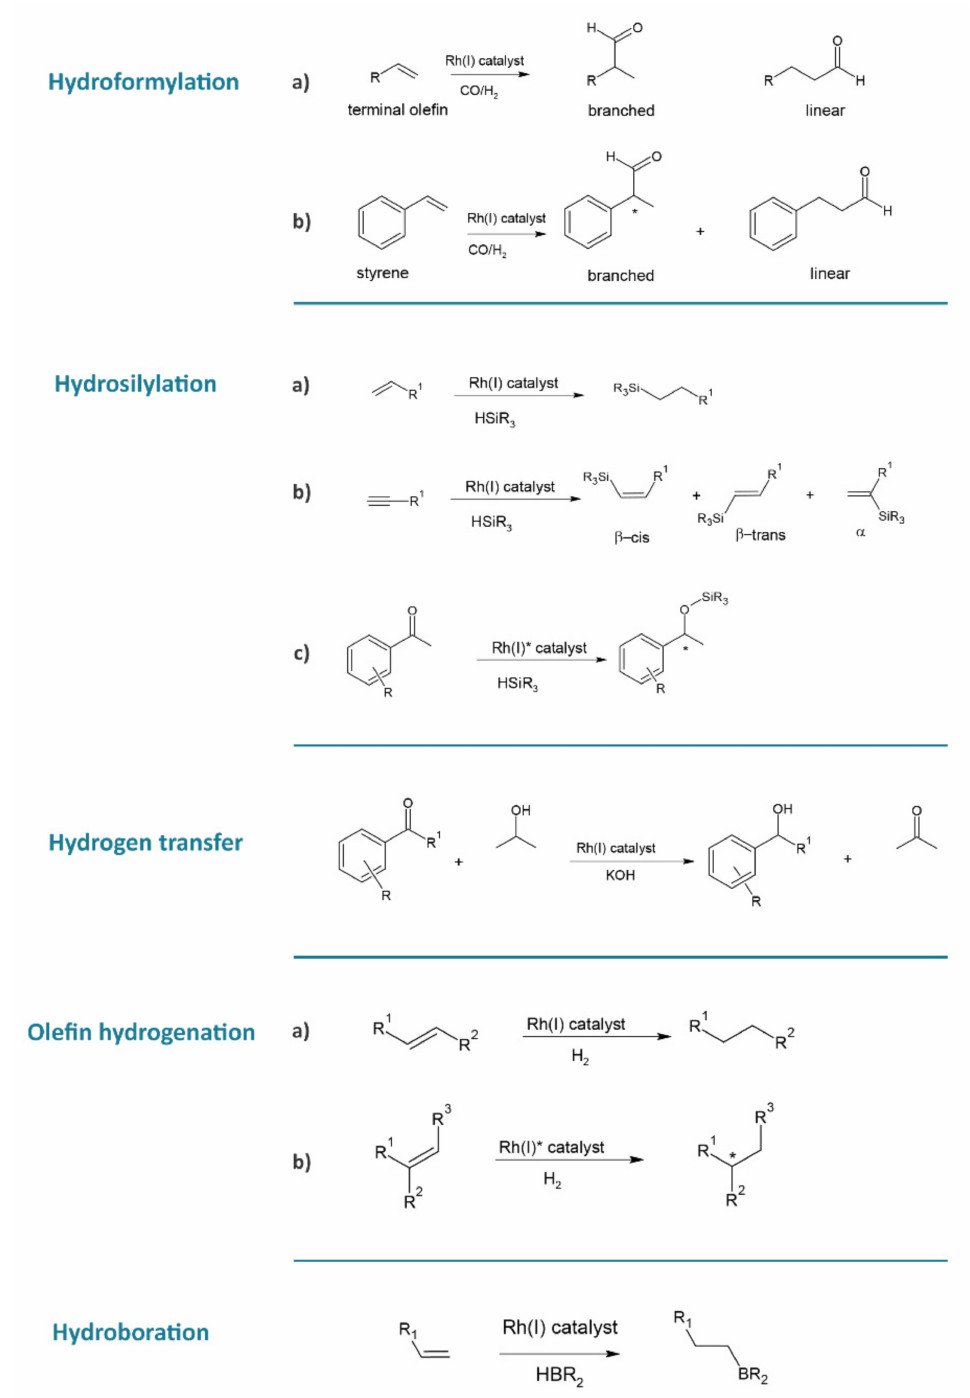
Chart 2. General reaction schemes for most common catalytic